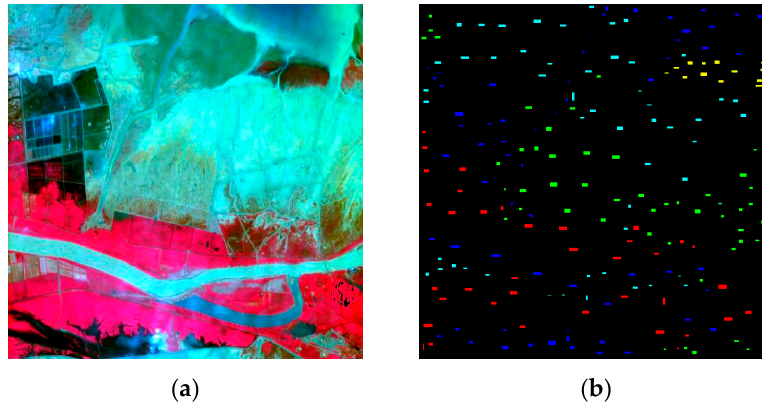
Figure 6. Training samples distribution. ( a ) False color image composite (band 15, 10 and 5); ( b ) ground truth of training samples. Table 4. Land cover classes and the number of training samples for Yellow River Mouth wetland data set.